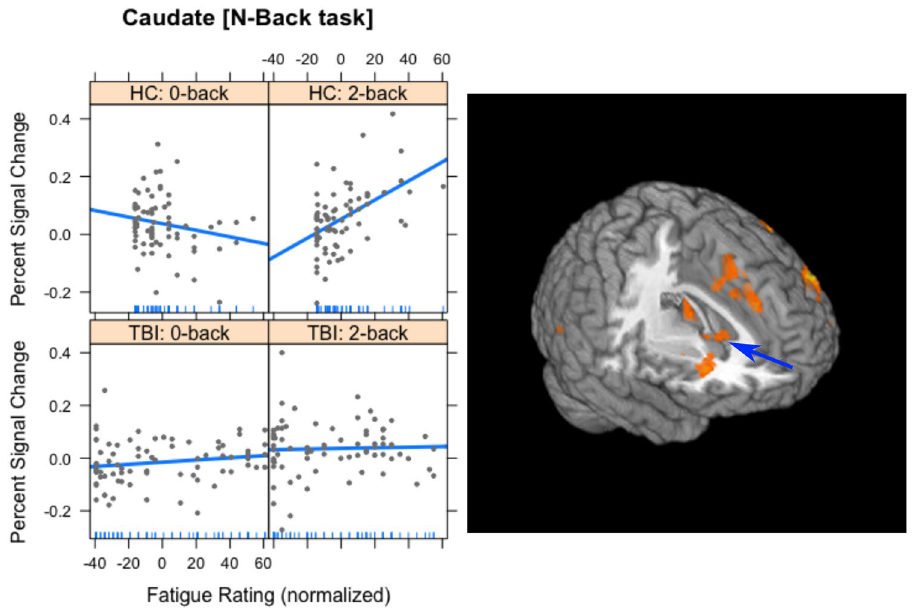
Figure 2. The interaction of Group, Task and Fatigue in Experiment 1 in the caudate head (indicated by blue arrow). The plots on the left are included only to show the slopes of the regression lines. For the HC group, there was a negative correlation between fatigue and activation for the 0-back task (top left), and a positive correlation for the 2-back task (top right). For the TBI group, the correlations between fatigue and activation in both tasks were very weak (lower plots). In all cases, the vertical axis is the percent signal change in the caudate head and the horizontal axis is the normalized fatigue score. On the right is a 3-dimensional rendering of the activation in the caudate head for Experiment